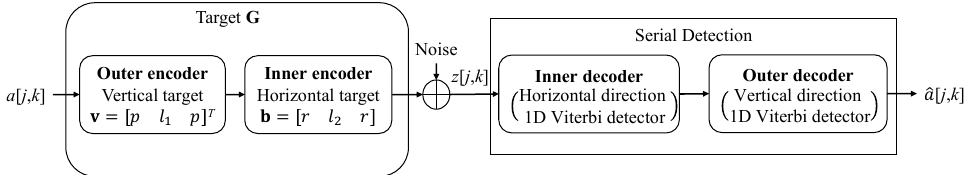
Figure 2. Ideal channel and detection model.